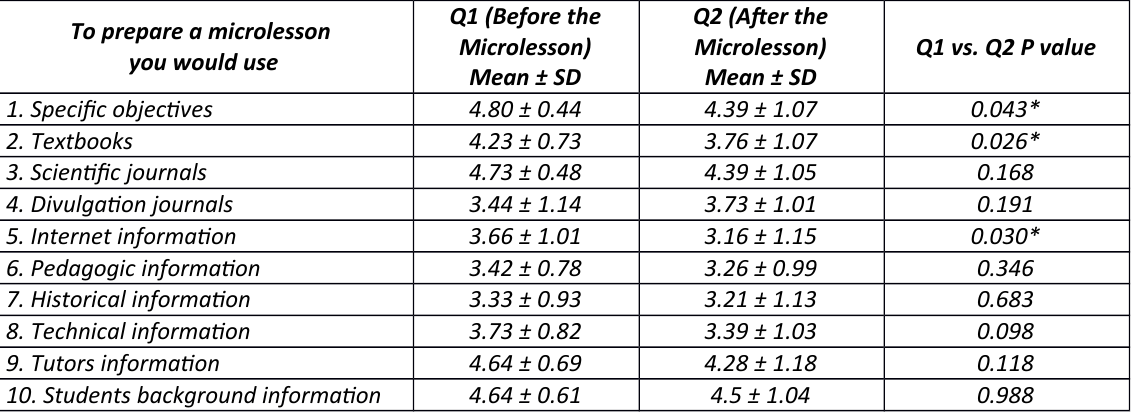
Table 1. Results obtained with the first questionnaire before the microlesson session (Q1) and after the microlesson session (Q2) and statistical comparison of both results. The results are shown as means±standard deviations, and the statistical comparison is shown as p values for the Mann-Whitney test. Statistically